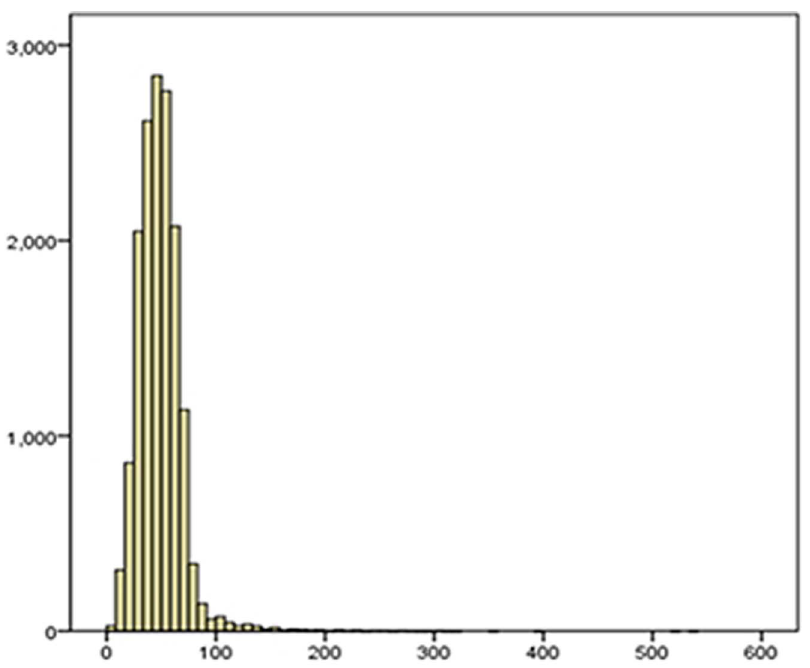
Figure 1. Distribution of blood lead levels among the out-patients in Wuhan. The horizontal axis represents the BLL values, and the vertical axis represents its frequency. Most of Children had BLLs below 100 m g/L, and only 310 children had BLLs higher than 100 m